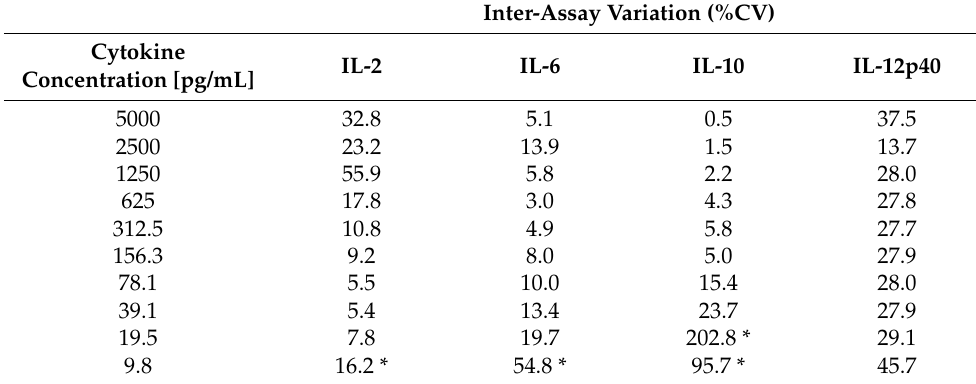
Table 5. Inter-assay (between plates) variations for calibration curve